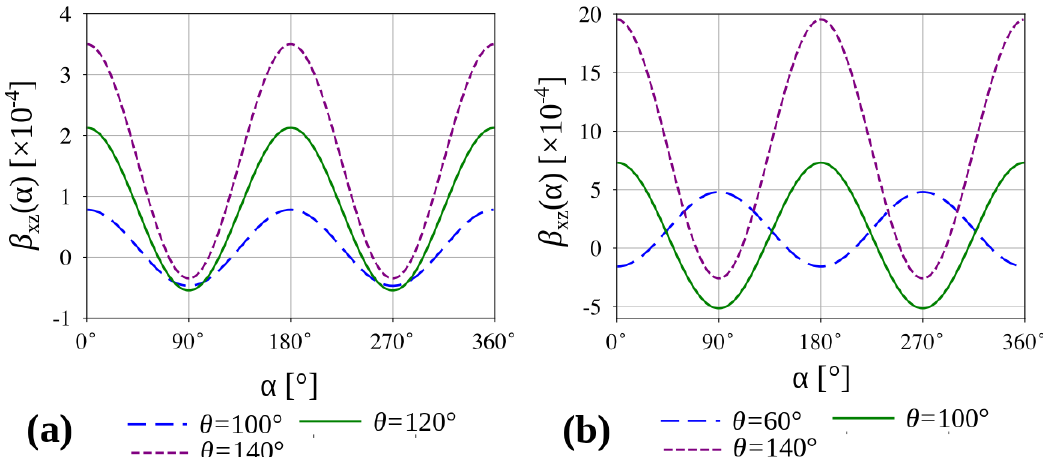
Figure 6. Linear compressibility measured in the xz plane (the same results would be obtained in the yz plane). Panels show ( a ) linear compressibility of the system where l a / l b = 3 and ( b ) linear compressibility of the system correspond to the l a / l b = 1.1